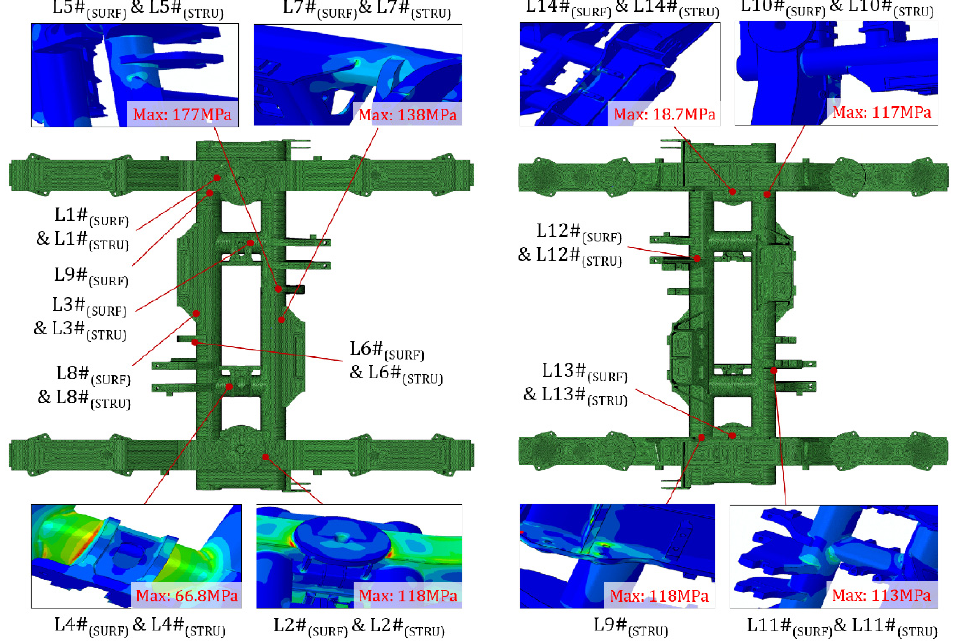
Figure 4. Location of capture and assessment